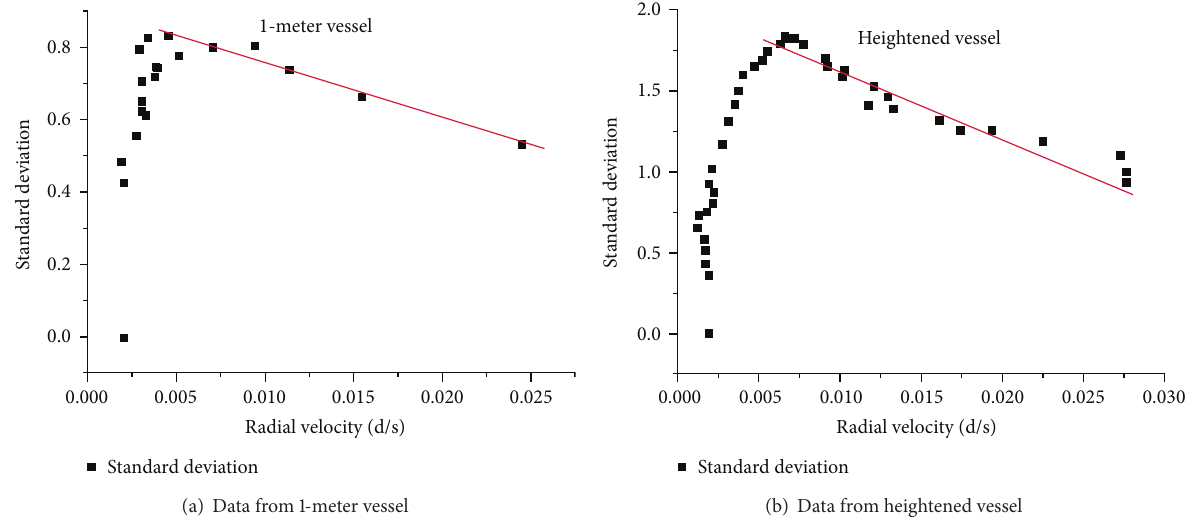
Figure 10: Correlation between standard deviation and radial velocity in 1-meter and heightened